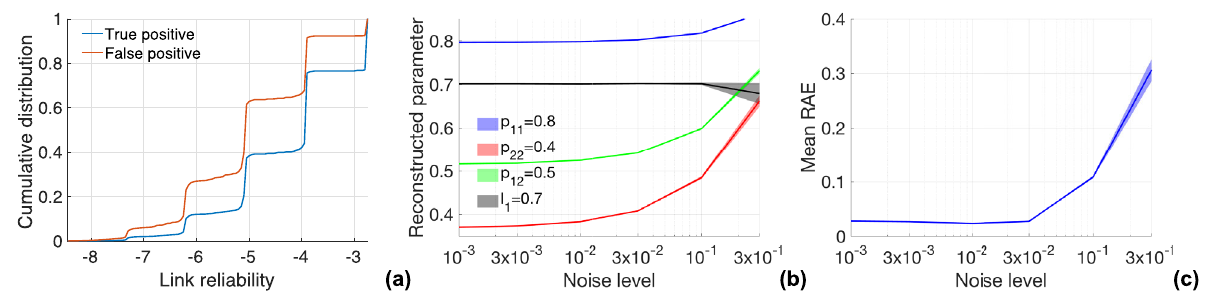
Fig. 5 Model reconstruction from noisy observations. a Cumulative distribution of link reliability with different labels, true positive and false positive. Fake links are added to a synthetic graph with spurious linking probability p = 10 − 1 (noise level) and the model is estimated from this noisy graph. The portion of spurious links with low reliability is larger than the portion of true connections. b Reconstructed parameters with different noise level (spurious linking probability p = 10 − 3 , 3 × 10 − 3 , 10 − 2 , 3 × 10 − 2 , 10 − 1 , 3 × 10 − 1 ). The estimations run 10 times with each noise level p and the mean and deviation are shown as lines and shaded areas respectively. The ground-truth parameters are presented in the legend. It shows that the estimated parameters increase as the noise level grows because more spurious links are added to the the original network. c Estimation errors with different noise level. Mean and standard deviation of the mean relative absolute error (RAE) are shown in the plot. The error is low (smaller than 5%) when the noise level p ≤ 3 × 10 − Revealing the network generators of Drosophila brain connectome .